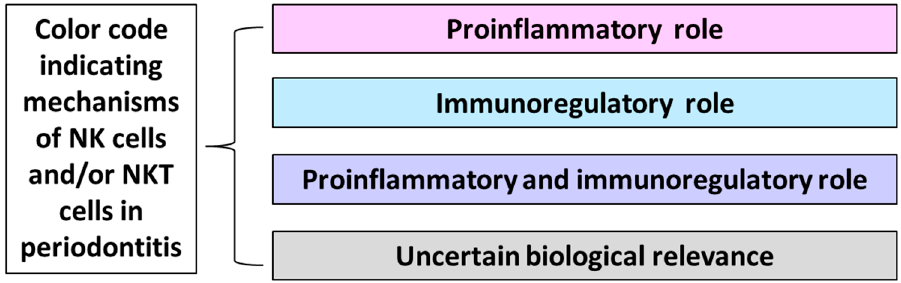
Figure 2. Color code indicating mechanisms of natural killer (NK) cells and/or natural killer T (NKT) cells in periodontitis.